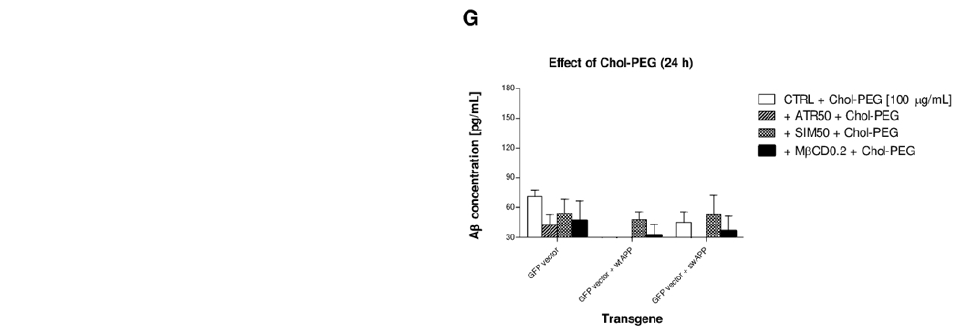
Figure 3. Effect of mevalonate (MEV, 100 μ M), dolichol (DOH, 0.1 μ g/mL), ubiquinol (UBOH, 10 μ g/mL), farnesol (FOH, 10 μ M), geranylgeraniol (GGOH, 10 μ M) or water soluble cholesterol ( Chol-PEG, 1 mM) on amyloid- β (A β 40 ) secretion by neurnal PC-12 cells affected by MEV pathway